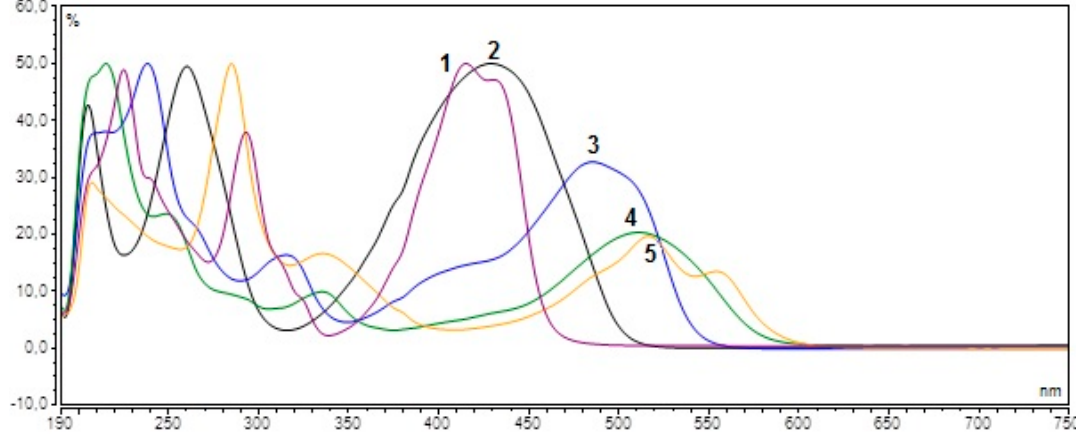
Figure 2. UV/VIS spectra of coloring standards. Peaks identity: 1—Quinoline Yellow (E104); 2—Tartrazine (E102); 3—Sunset Yellow (E110); 4—Ponceau 4R (E124); 5—Carmine (E120).